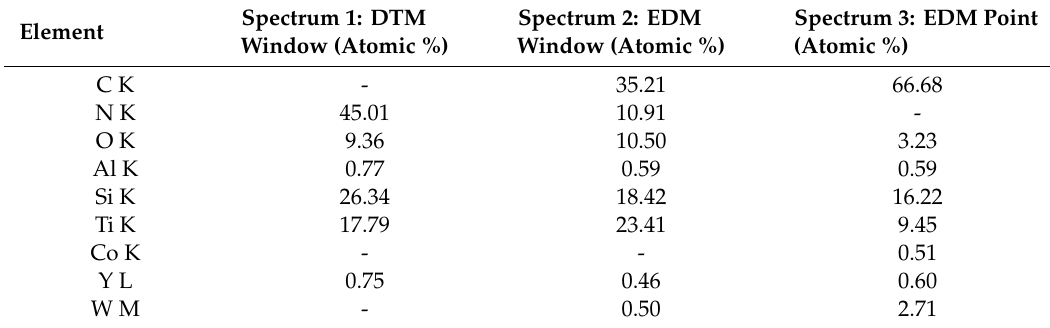
Table 3. EDS element